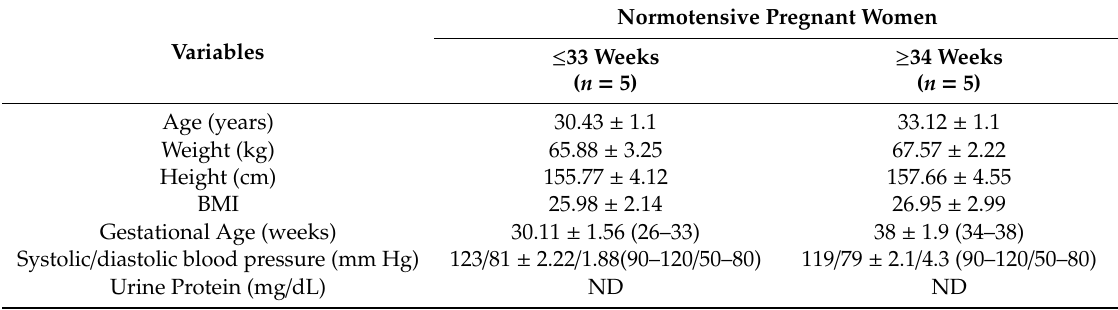
Table 1. Clinical Characteristics of